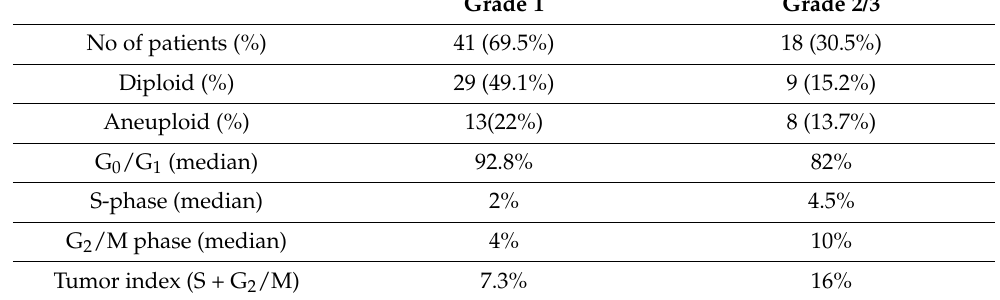
Table 1. Patient characteristics regarding iFC and Ki-67 staining results.